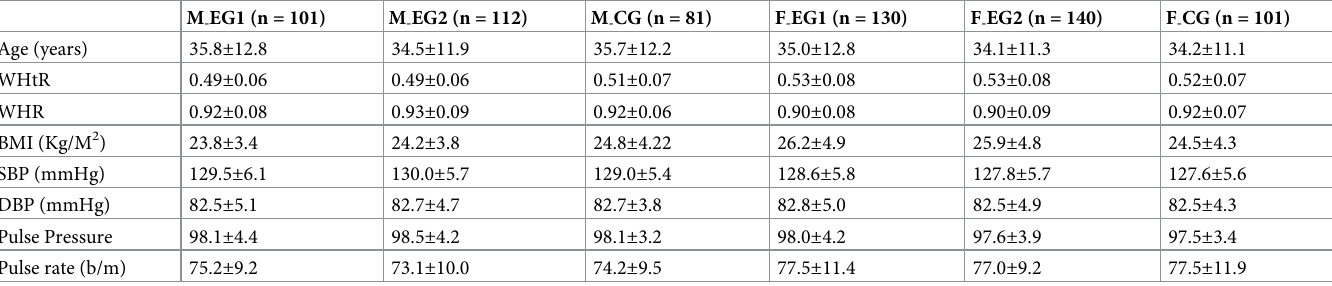
Table 1. Baseline bio-demographic characteristics of the participants. M - EG1 (n =